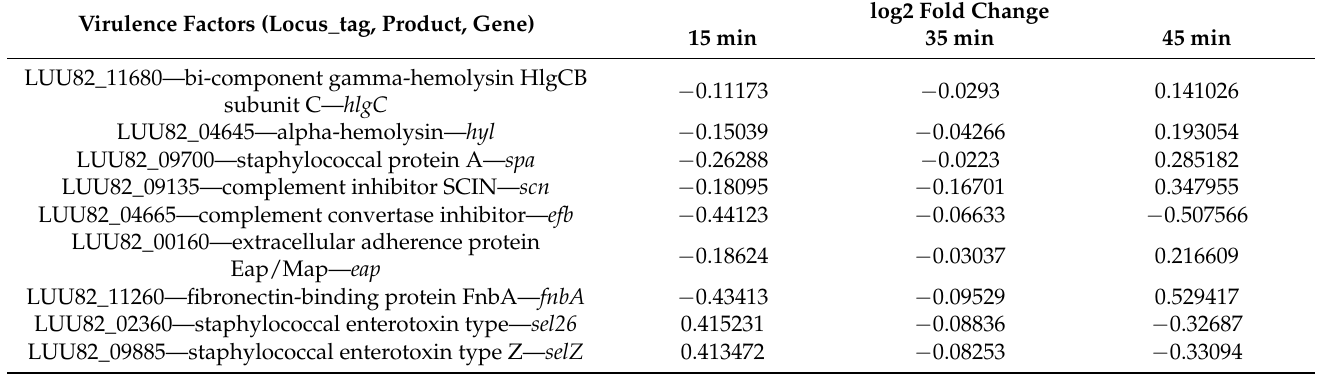
Table 2. List of virulence-factor genes of S. aureus strain E1185(IV)ST12 that experience up/downregulation during infection of Staphlococcus phage SAM1 ( p < 0.05,